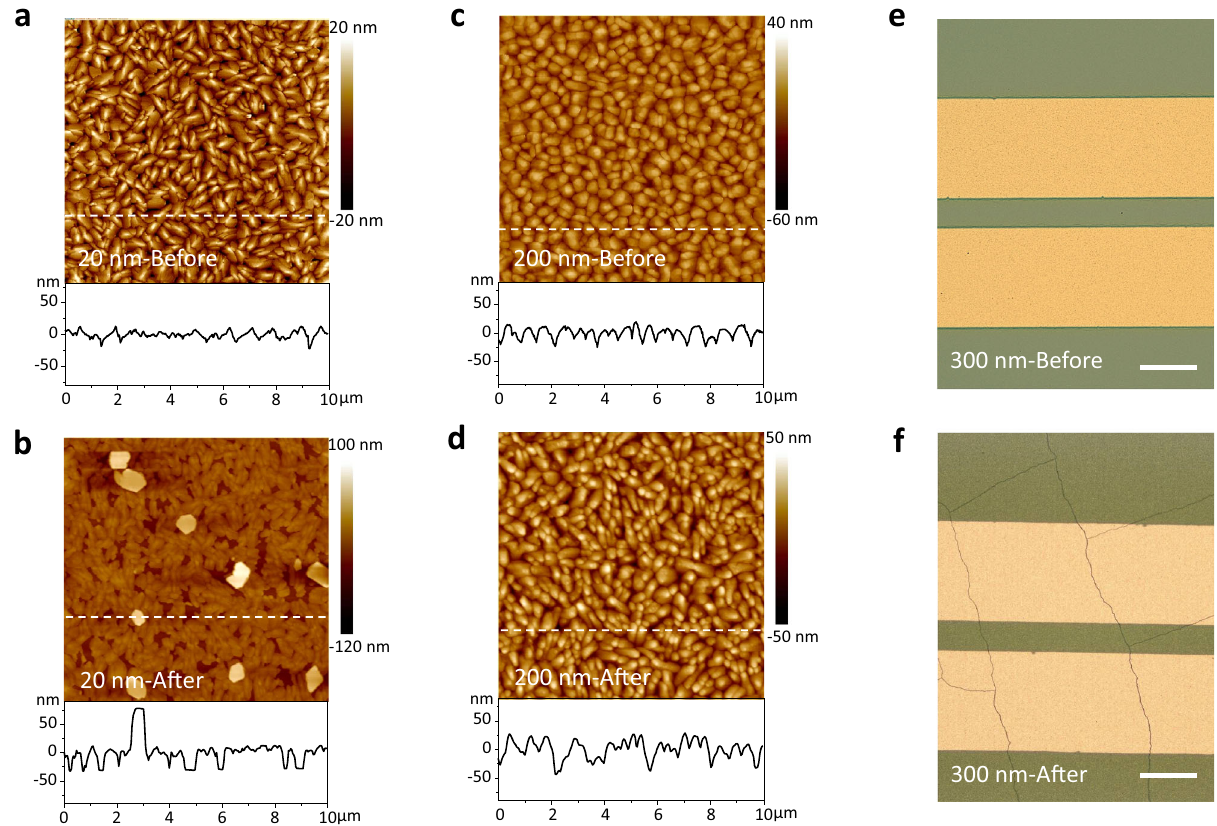
Fig. 2 Aggregate state stability of DNTT fi lms. a – d Atomic force microscope images and section pro fi les of the 20 and 200 nm DNTT fi lms before and after fi ve years of storage. Optical images of 300 nm DNTT fi lm e before and f after four months of storage by confocal laser scanning microscopy. The scale bar in e and f is 200 μ